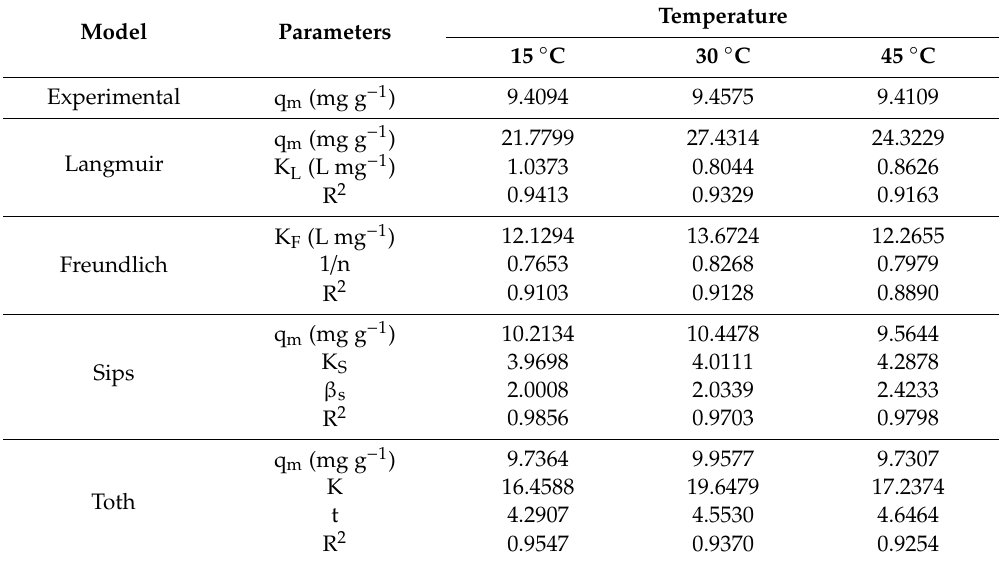
Table 2. Calculated parameters for isotherm adsorption models. q m is the maximum adsorption capacity; K L is the Langmuir adsorption constant; K F and n are Freundlich constants; K S and β s are Sips constants; K and t are Toth